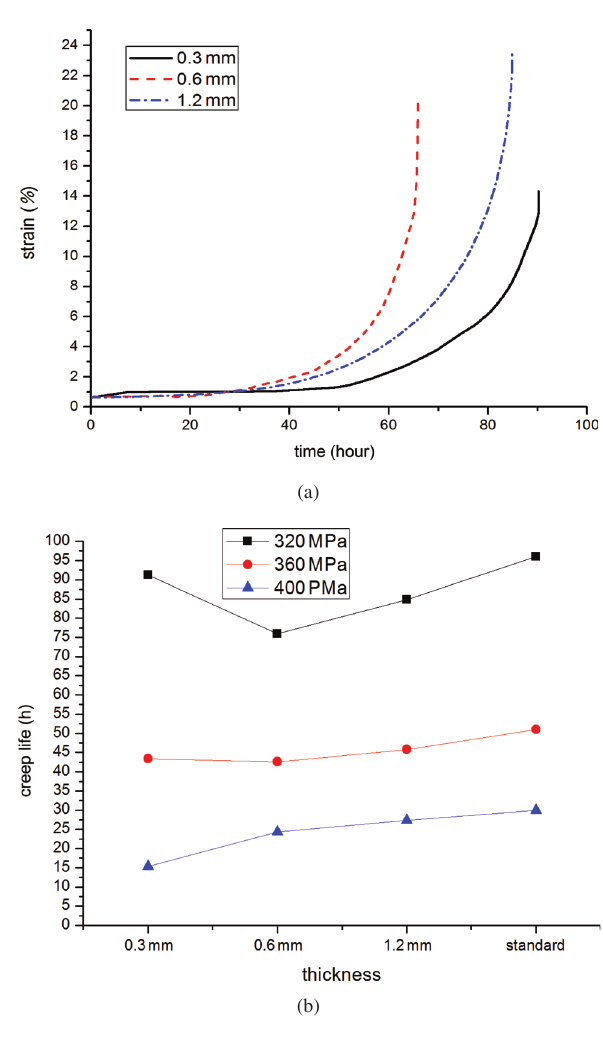
Figure 4: (a) Creep strain vs. time, curves for sheet specimens with δ = 0.3 mm, 0.6 mm and 1.2 mm tested at 980 ℃ /320 MPa. (b) Effect of specimen thickness on the average rupture life at 980 ℃ /320 MPa, 360 MPa and 400